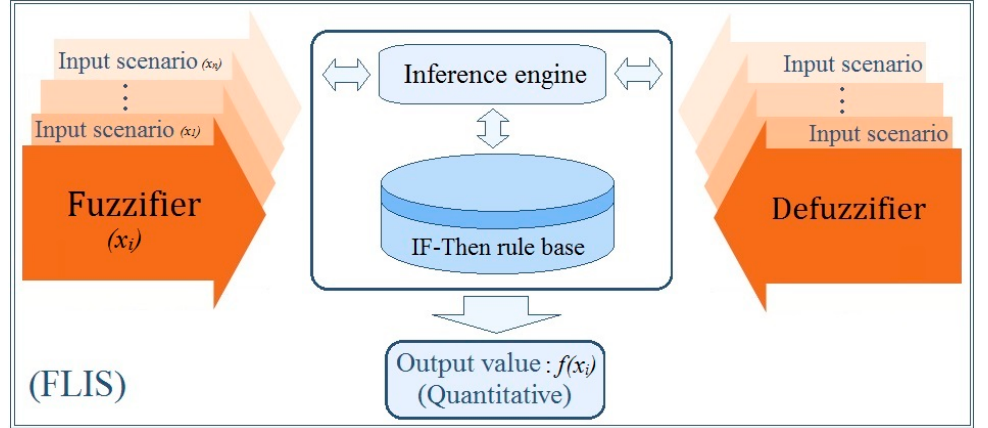
Figure 3. Schematic diagram of inference in FLIS. There are 45 different input scenarios ( x i ), and the corresponding output value is presented as f ( x i ). The fuzzy set and the fuzzy range are established by MATLAB. The output values of the parameters are shown in Table 7. Table 7. Definition of parameters in FLIS with MATLAB.